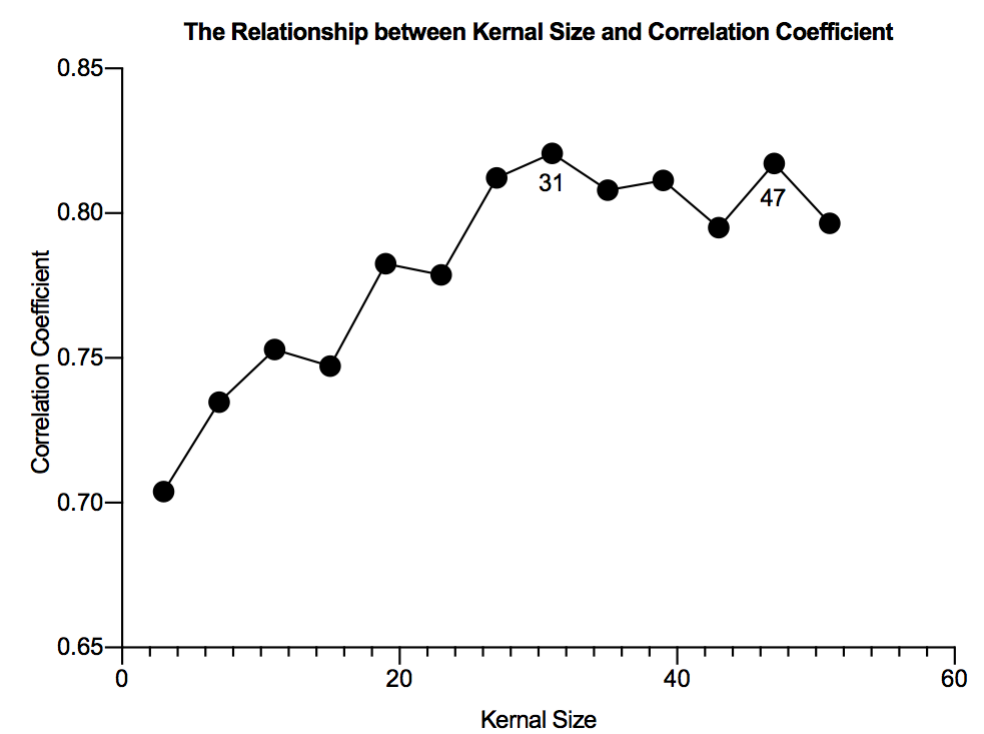
Figure 5. The relationship between kernel size and